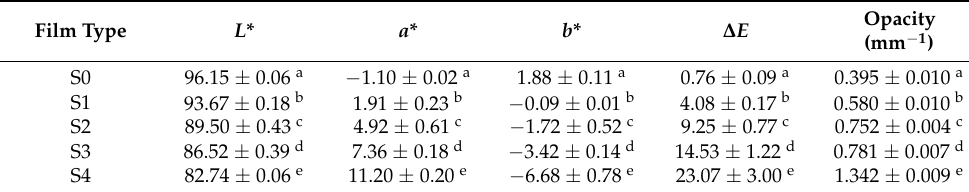
Table 3. Color and opacity of active films with different RCAE